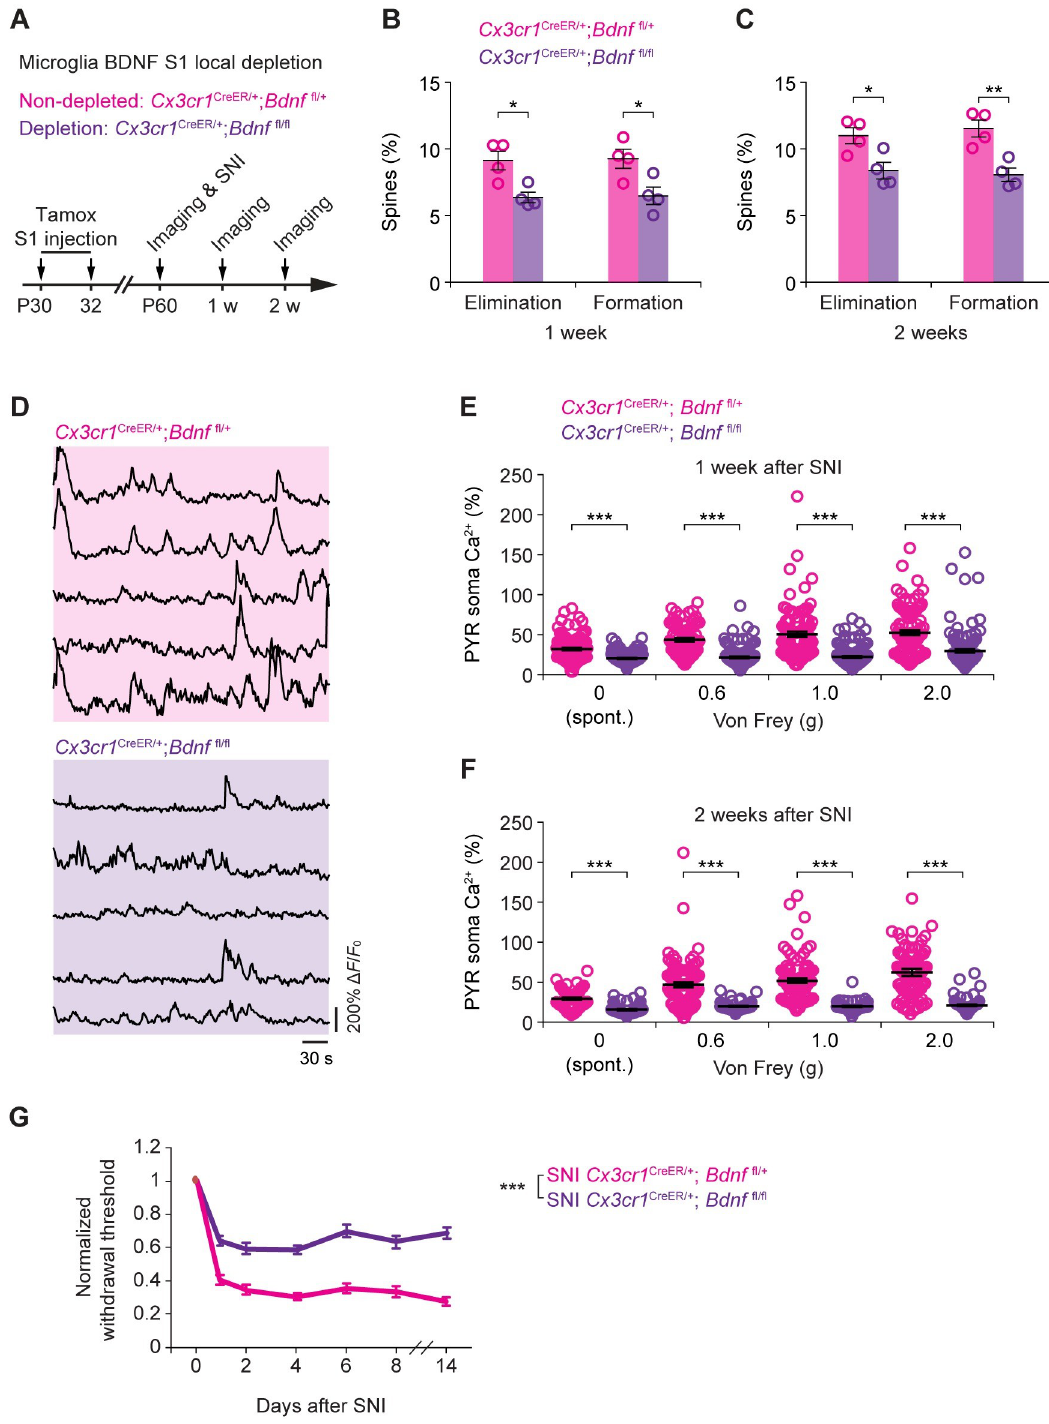
Fig 8. S1-targeted microglial BDNF depletion reduces somatosensory cortical plasticity and allodynia. ( A ) Experimental timeline. ( B, C ) Percentages of dendritic spine elimination and formation 1 week ( B ) or 2 weeks ( C ) after SNI in mice with or without S1 microglial BDNF ( Cx3cr1 CreER/+ ; Bdnf fl/+ : 590 spines, n = 4 mice; Cx3cr1 CreER/+ ; Bdnf fl/fl : 594 spines, n = 4 mice). ( D ) Representative fluorescence traces of L5 PYR somas expressing GCaMP6s in SNI mice with ( Cx3cr1 CreER/+ ; Bdnf fl/+ ) or without ( Cx3cr1 CreER/+ ; Bdnf fl/fl ) S1 microglial BDNF. ( E ) Averaged Ca 2+ activity 1 week after SNI (0 g: t 218 = 7.323, P < 0.001; 0.6 g: t 195 = 9.555, P < 0.001; 1.0 g: t 230 = 9.464, P < 0.001; 2.0 g: t 220 = 6.399, P < 0.001). ( F ) Averaged Ca 2+ activity 2 weeks after SNI (0 g: t 154 =